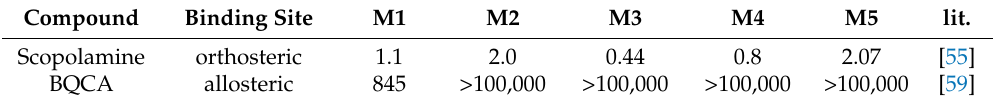
Table 2. Binding parameters of well-known mAChR ligands given in nM. Data of scopolamine is given as K i values from a competitive radioligand binding assay using [ 3 H]NMS. Values of BQCA are given as inflection point of ACh efficacy potentiation as measured by calcium